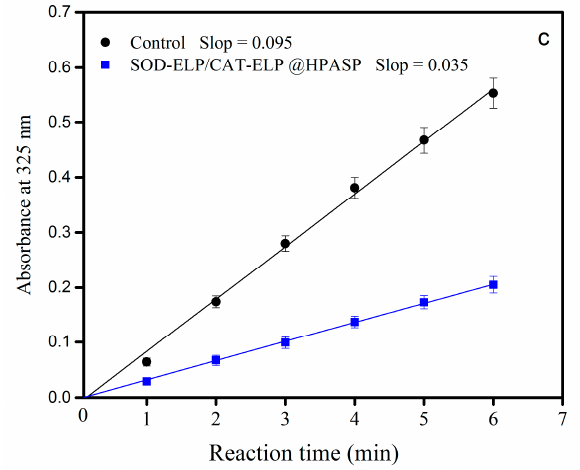
Figure 7. ( a ) Absorption with reaction time without enzyme; ( b ) Absorption with reaction time with the co ‐ immobilized enzyme SOD ‐ ELP/CAT ‐ ELP@HPASP; ( c ) Stern ‐ Volmer plots for the quenching of enzyme fluorescence by acrylamide. F 0 and F are the fluorescence intensities in the absence and presence of acrylamide,